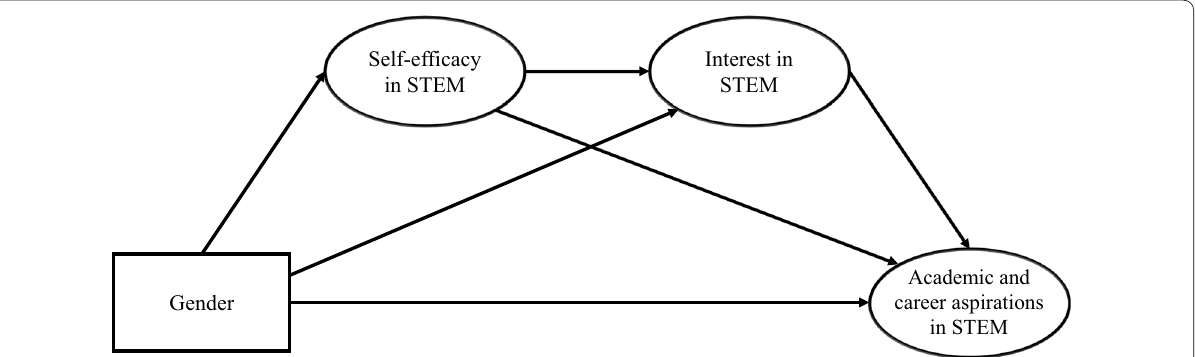
Fig. 1 Hypothesized mediation model of gender differences in self-efficacy, interest, and academic and career aspirations in